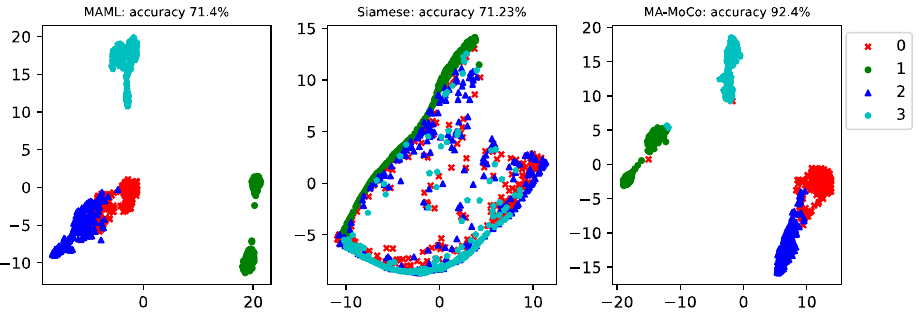
Figure 5. A 4-way 1-shot diagnosis of the generator bearing data when the training set of each class has only 20 fault samples.